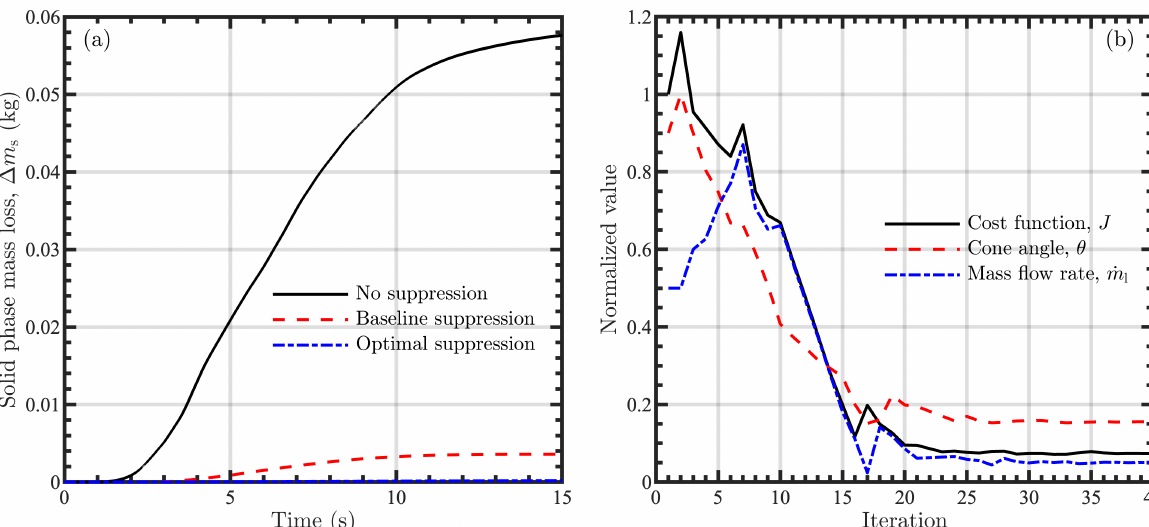
Figure 11. Solid-phase mass loss comparison for panel fire spread cases with and without water sprinkler suppression ( a ) and convergence history for the optimization ( b ). Panel ( a ) shows the mass loss for cases with no suppression (solid black line), baseline suppression parameters (dashed red line), and optimal suppression parameters (dash-dot blue line). Panel ( b ) shows normalized values of the cost function J from Equation (14) (solid black line), the cone angle θ (dashed red line), and the mass flow rate ˙ m l (dash-dot blue